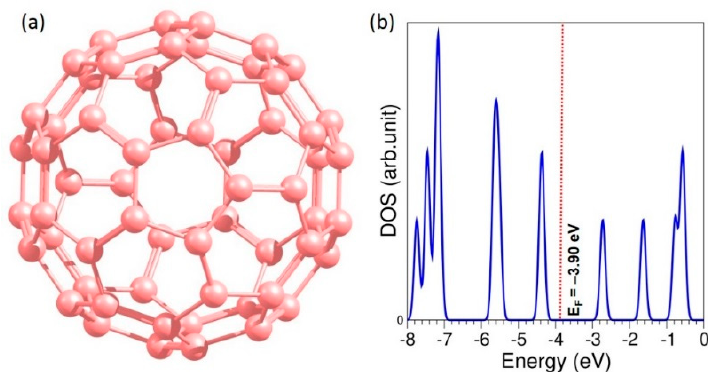
Figure 1. Relaxed structure of ( a ) C 60 and ( b ) its DOS plot.